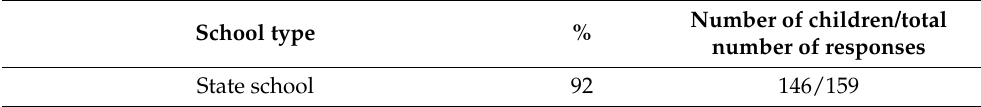
Table 1. School type, age group and provision of